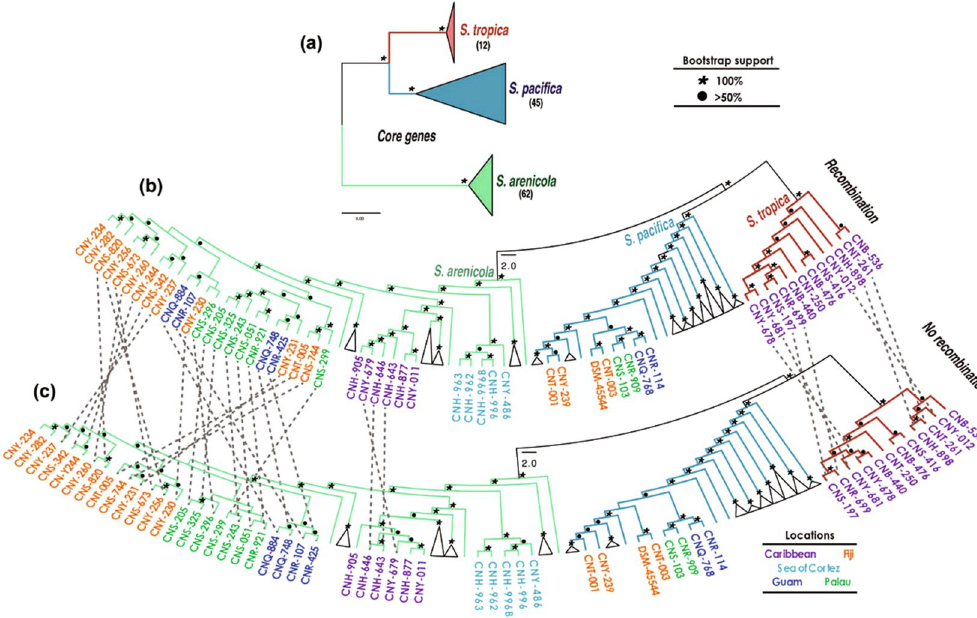
Figure 3. Salinispora maximum likelihood phylogeny. ( a ) Collapsed phylogenomic tree based on a concatenation of 2362 shared, single-copy genes. Number of strains analyzed for each species is shown in parentheses. Non-collapsed trees are presented in Fig. 5. ( b) Phylogeny based on genes with evidence of recombination. ( c) Phylogeny based on genes with no evidence of recombination. Strain numbers are given in cases where the tree topologies differ. When possible, branches with the same topology in both trees were collapsed. Dashed lines depict positional changes of strains in the trees. Branches are color-coded by species. Symbols on the branches represent the support from 1,000 bootstrap replicates. Strain numbers are color-coded by